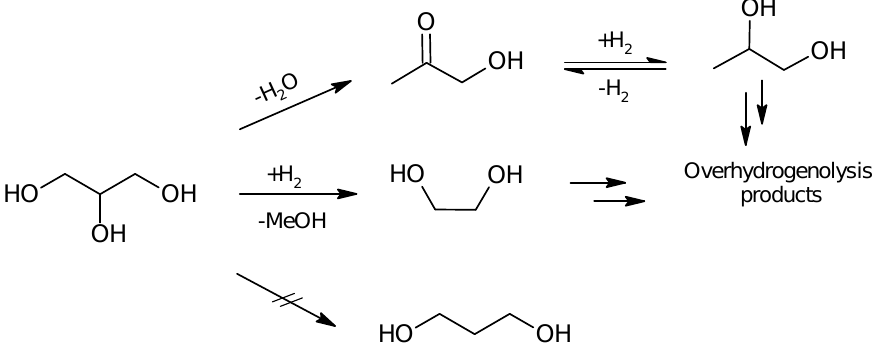
Figure 11. Reaction pathways of the hydrodeoxygenation of glycerol over Cu/ZrO 2 catalysts as proposed by Gabrysh et al. [46] (Copyright © 2022 John Wiley and Sons Reproduced with permission).